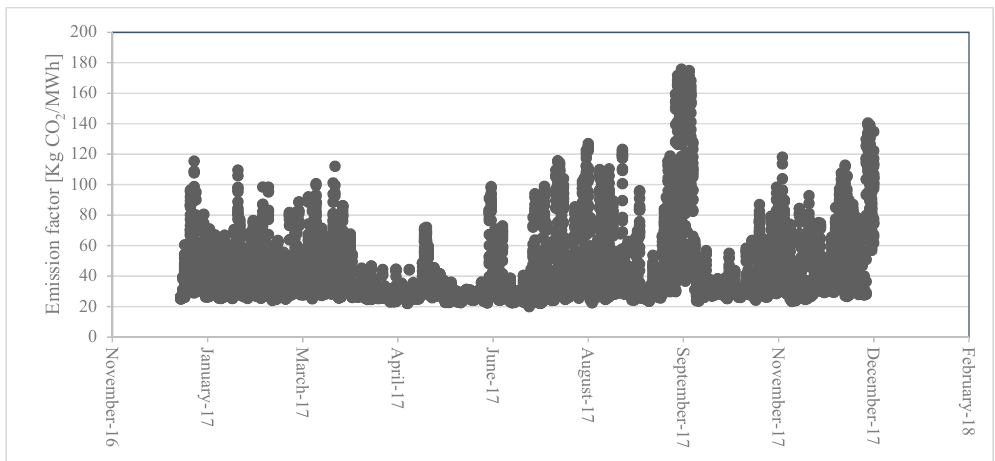
Figure 3. Hourly emission factor of Ontario’s electricity mix for 2017 [30] .